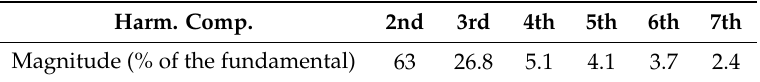
Table 8. Harmonic components of the test signal. Harm. Comp.